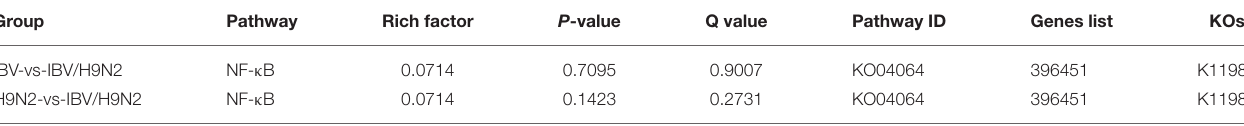
TABLE 2 | Immune-related pathway enrichment statistics of DEGs upon in chicken trachea of different infection groups. Group Pathway Rich factor P -value Q value Pathway